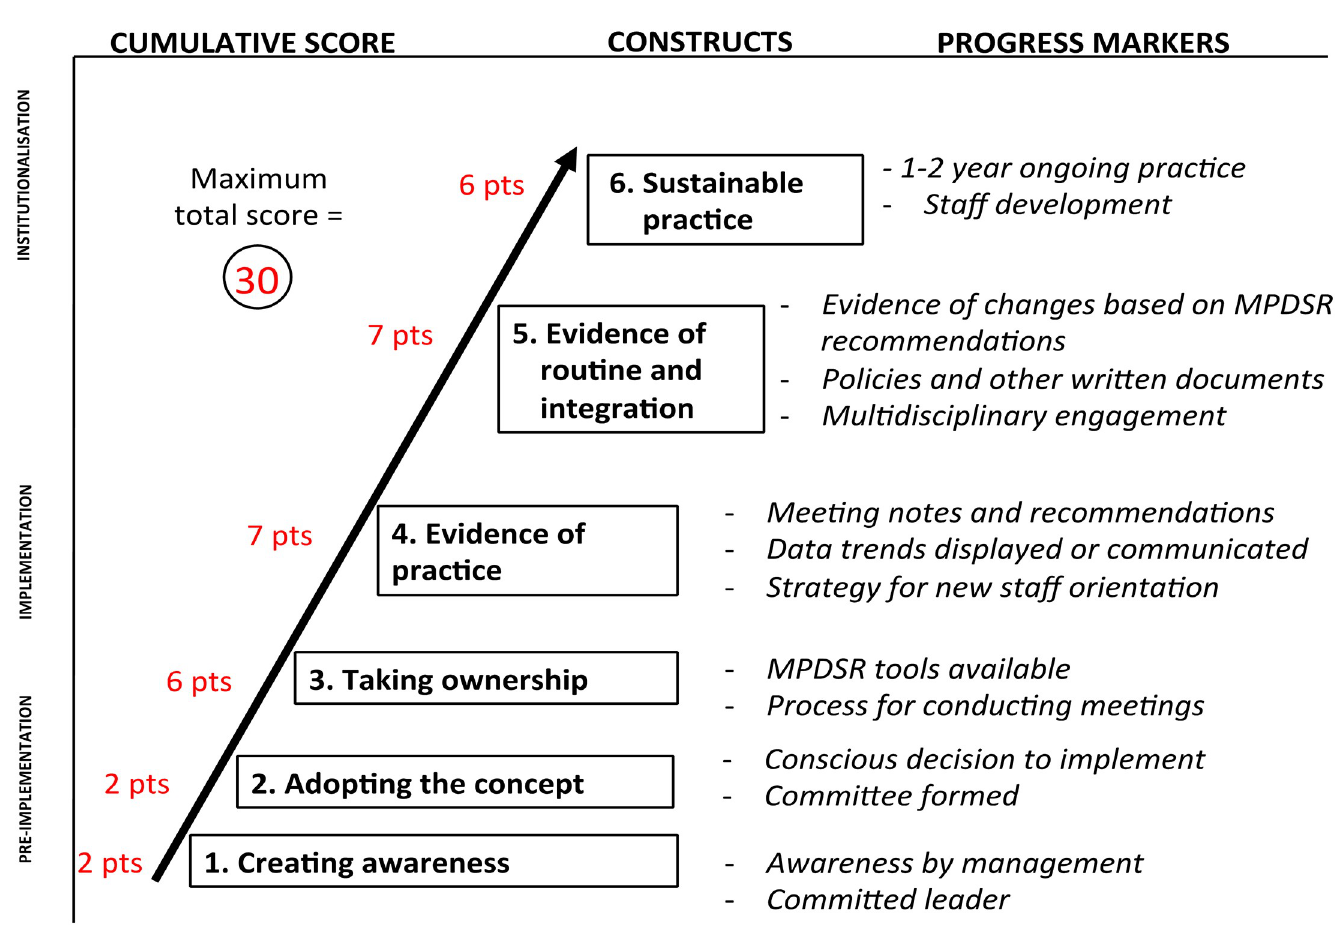
Fig 1. Implementation progress scoring